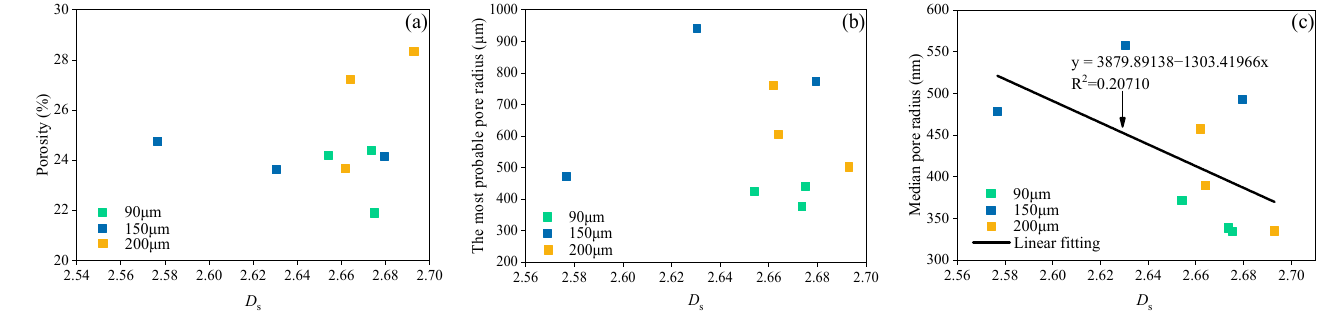
Figure 7. Bi-logarithmic plots of ln with different pore-forming agent contents. ( a ) 30 vol.% pore formers (CF:Graphite = 3:7) + 70 vol.% alumina; ( b ) 30 vol.% pore formers (CF:Graphite = 5:5) + 70 vol.% alumina; ( c ) 30 vol.% pore formers (CF:Graphite = 7:3) + 70 vol.% alumina; ( d ) 50 vol.% pore formers (CF:Graphite = 3:7) + 50 vol.% alumina; ( e ) 50 vol.% pore formers (CF:Graphite = 5:5) + 50 vol.% alumina; ( f ) 50 vol.% pore formers (CF:Graphite = 7:3) + 50 vol.% alumina; ( g ) 70 vol.% pore formers (CF:Graphite = 3:7) + 30 vol.% alumina; ( h ) 70 vol.% pore formers (CF:Graphite = 5:5) + 30 vol.% alumina; ( i ) 70 vol.% pore formers (CF:Graphite = 7:3) + 30 vol.% alumina. Table 3. Surface fractal dimensions ( D s ) of porous alumina pore surfaces.